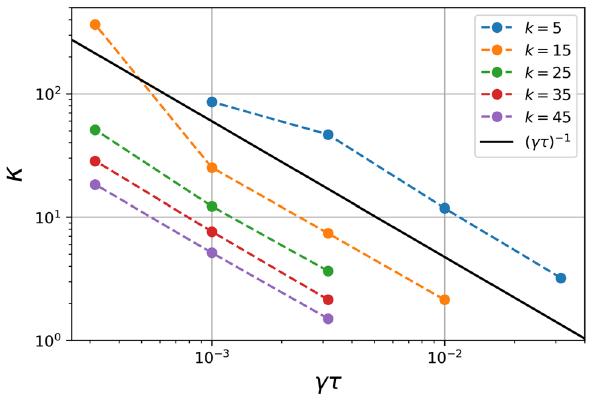
5 and k 45 . The solid = =